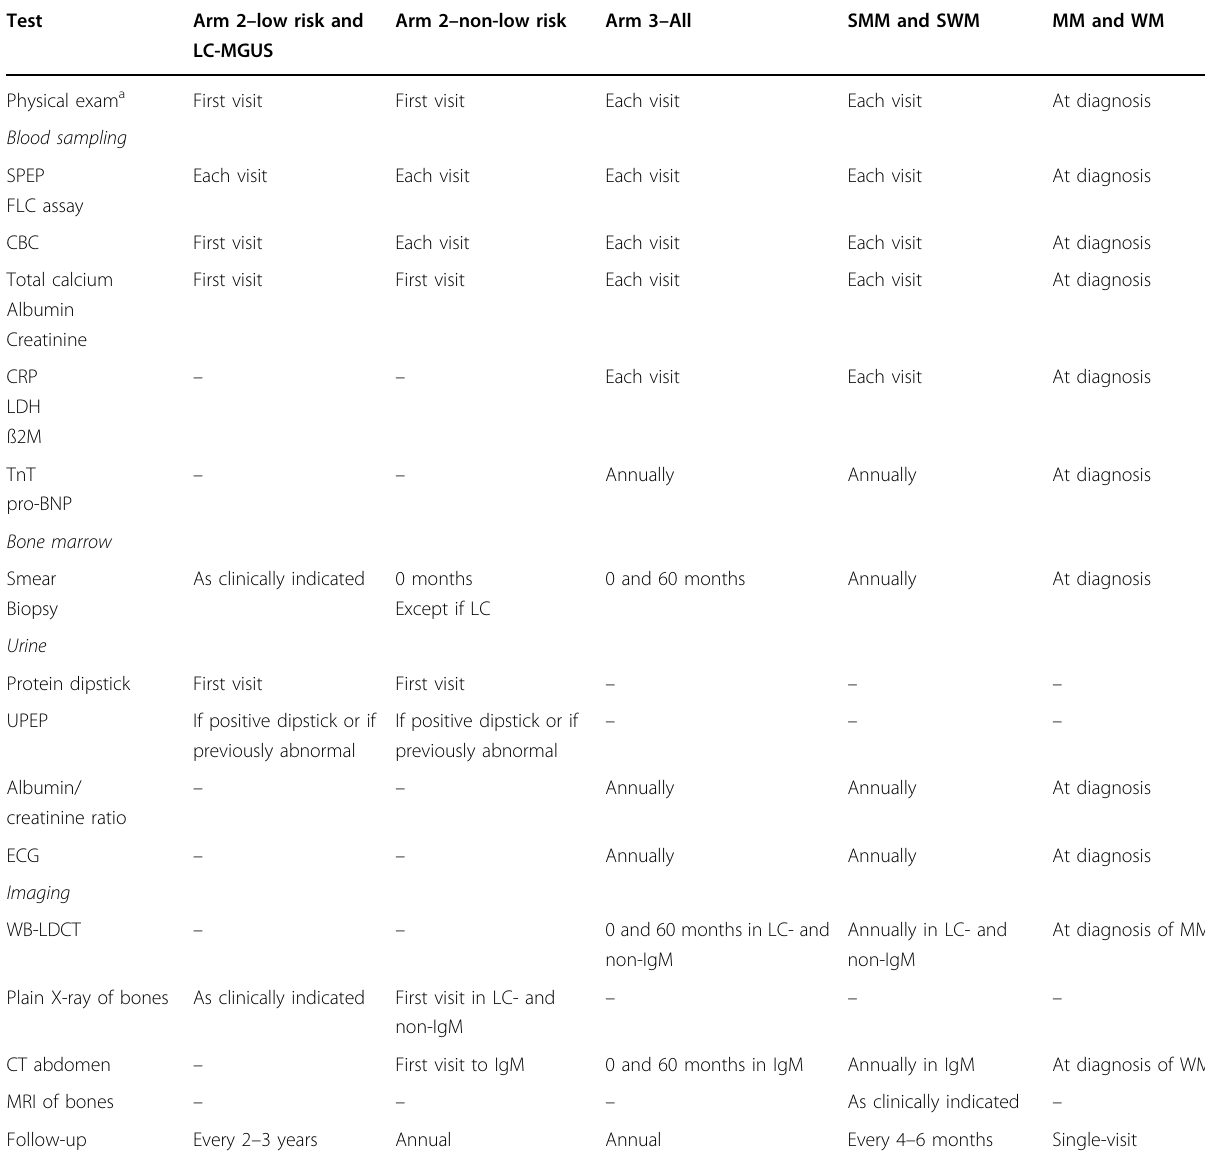
Table 1 Clinical assessment, imaging, and laboratory studies included for participants in the different study arms of the iStopMM study as per